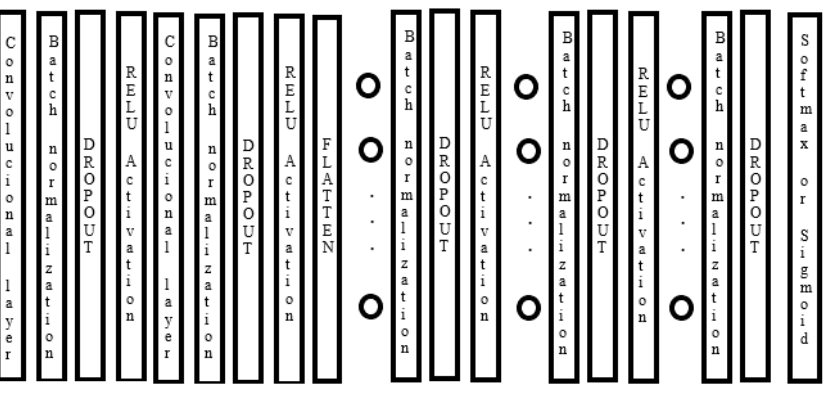
Figure 5. Convolutional neural network layout. Figure 4. Convolutional neural network layout.